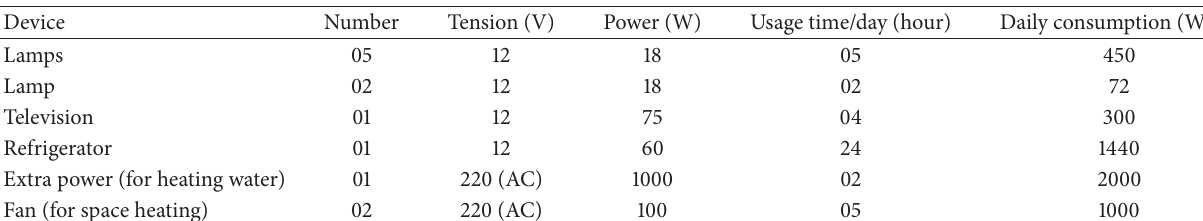
Table 1: Electrical load profile for a habitation in Gharda¨ıa.